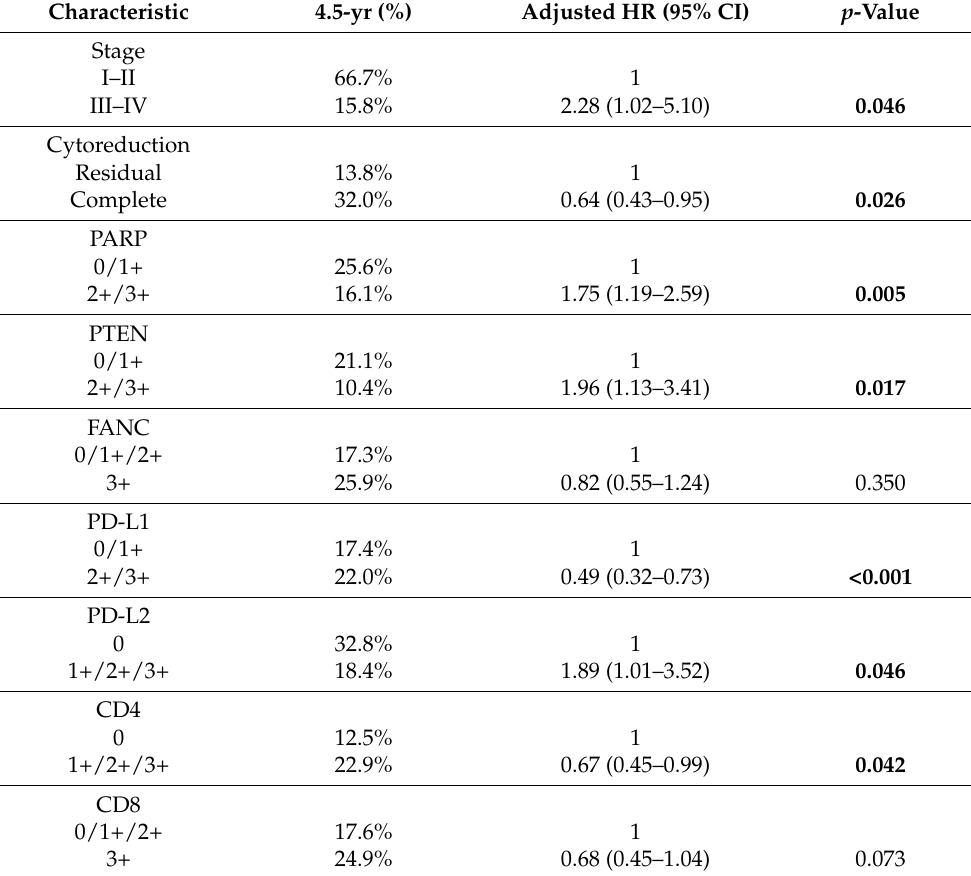
Table 4. Independent factors for progression-free survival ( n = 181, whole cohort).